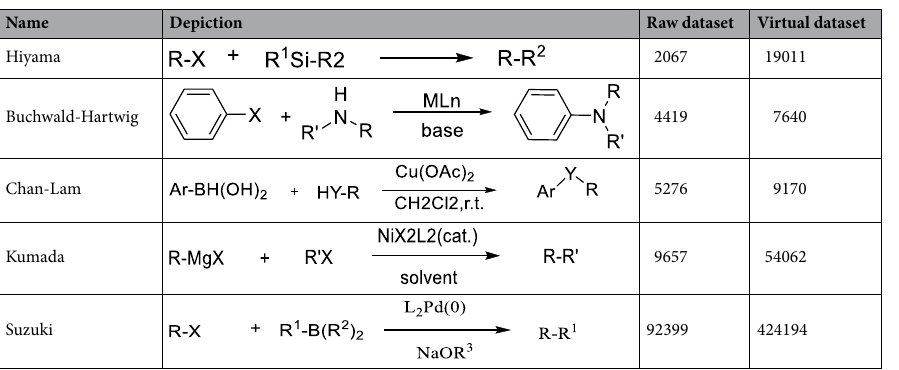
Table 1. Statistical Summary of five coupling reactions before and after using virtual data augmentation